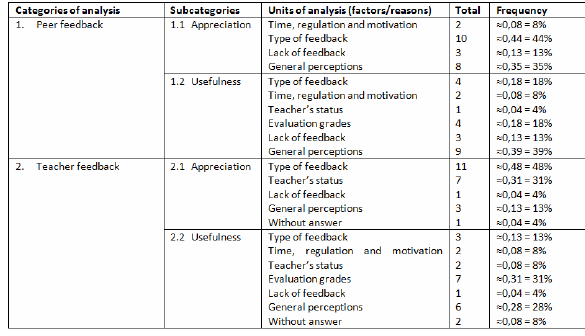
Figure 3. Categories of analysis for the open